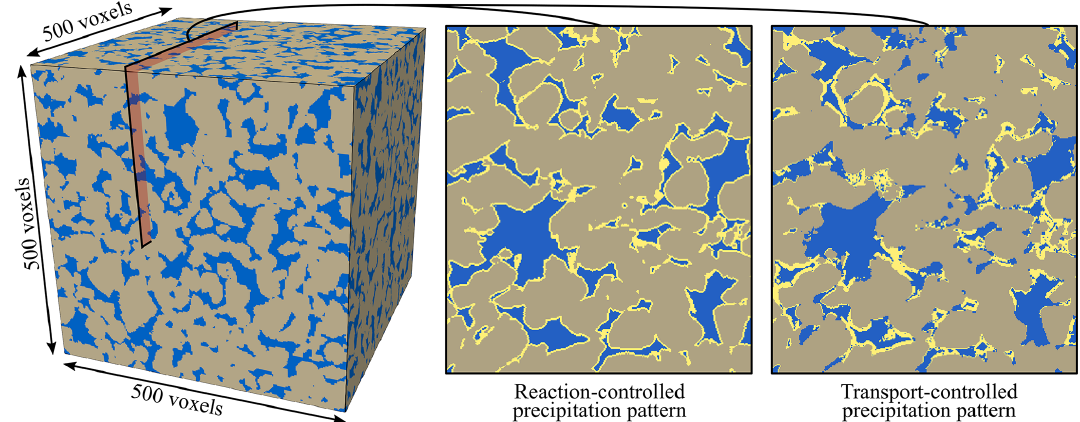
Figure 1. Binarised micro-CT scan of the Bentheim sandstone has an initial porosity of 23% and comprises pore space (blue) and grains (brown). Exemplary slices through the digital rock show the anhydrite cementation (yellow) for a reaction- and a transport-controlled pre- cipitation at a porosity of